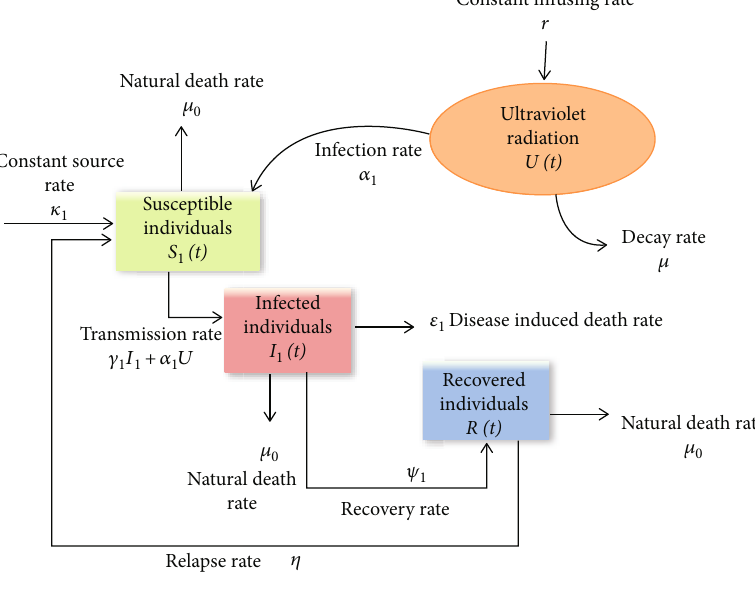
Figure 7: Flow diagram of skin cancer